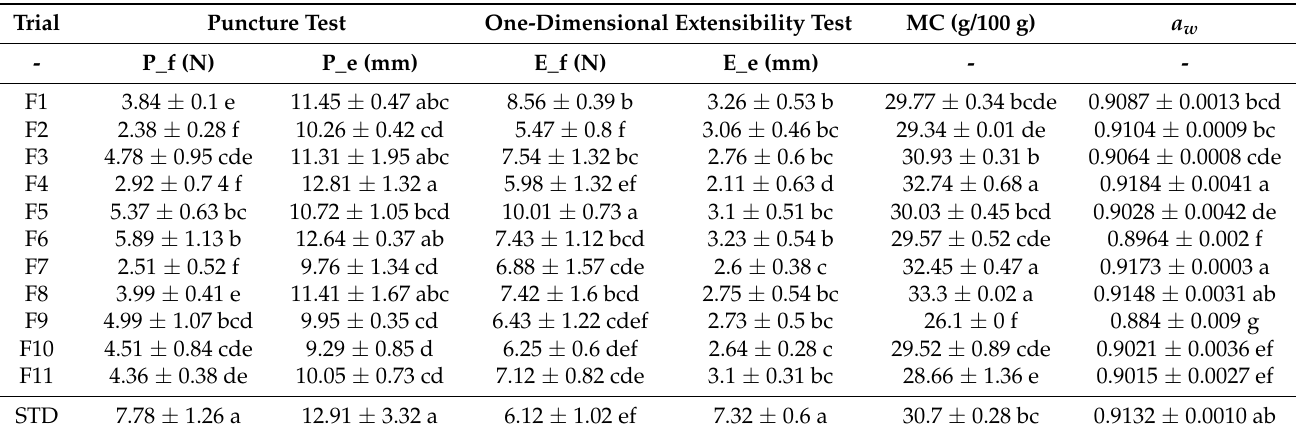
Table 2. Experimental design results of composite flour formulations (F1-F11) for flatbread develop- ment and comparison with the textural properties of a 100% W flatbread